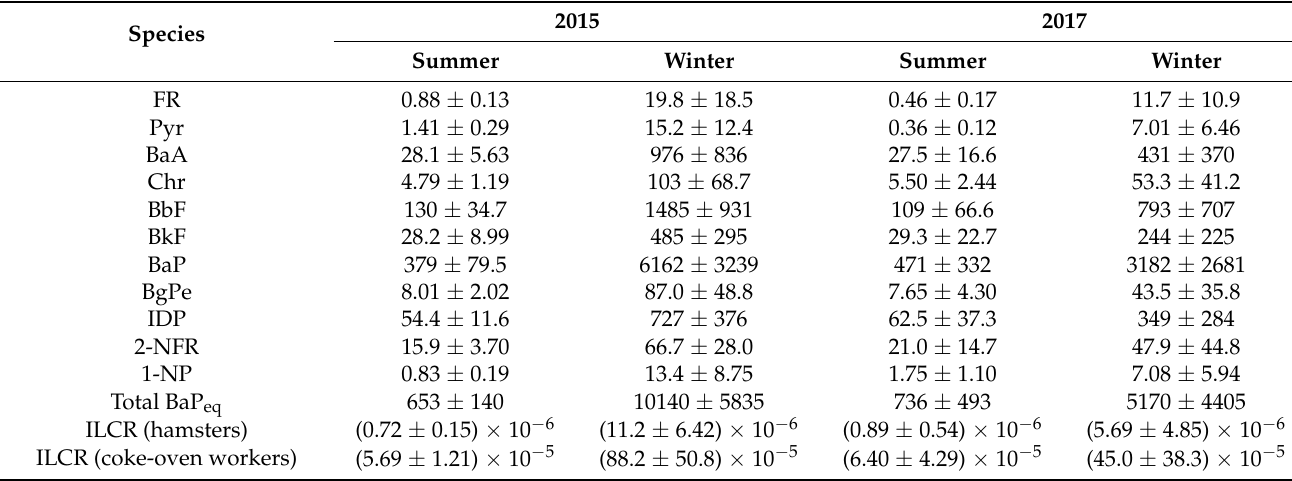
Table 4. The mean benzo[ a ]pyrene (BaP)-equivalent concentrations (pg/m 3 ), standard deviation (SD) and incremental lifetime cancer risk (ILCR) of PAHs and NPAHs in 2015 and